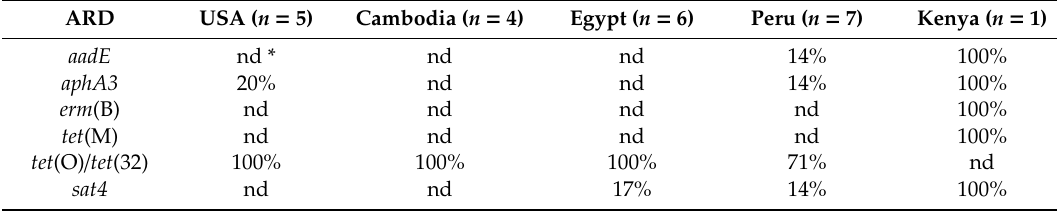
Table 2. ARDs detected in Campylobacter spp. by geographic location (percent of isolates